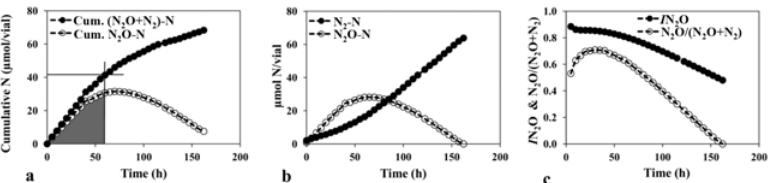
Fig 3. Demonstration of calculation of I N 2 O and N 2 O/(N 2 O+N 2 ). Representative curves for a) cumulative N accumulation, b) measured N, and c) N 2 O production index ( I N 2 O) and N 2 O/(N 2 O+N 2 ) product ratio over time for one soil (Moorepark). N 2 O production indices were calculated as IN 2 O ¼ Curves represent a single fl ask result. Each fl ask contained 20 g (dry weight) soil incubated in a 120 ml serum vial under anoxic conditions. Results for all other soils can be found in S1 Fig.